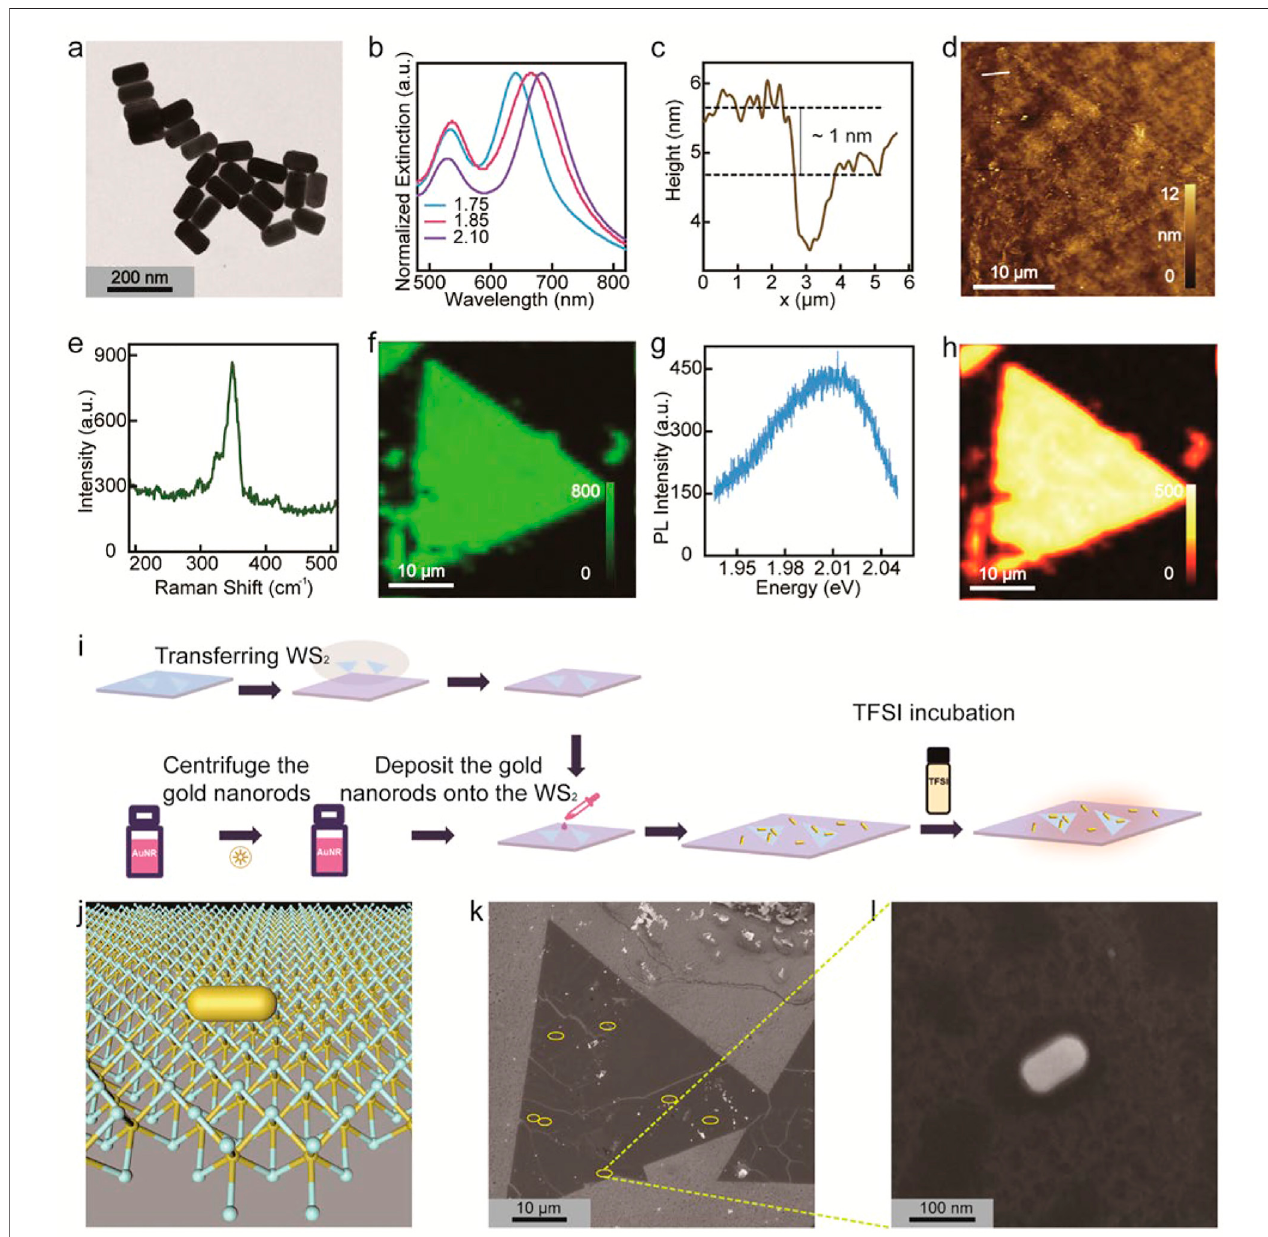
FIGURE 1 | Characterizations of gold nanorods and monolayer WS 2 . (A) Transmission electron microscopy (TEM) image of gold nanorods. (B) Normalized extinction spectra of three typical gold nanorod samples with different nanorod aspect ratios. Numbers next to the colored lines indicate the aspect ratios. (C, D) AFM topography (C) and image (D) of the monolayer WS 2 . The topography shown in (C) is collected along the white solid line shown in (D) . (E) Raman spectrum of the monolayer WS 2 fl ake. (F) 2D Raman intensity mapping of the sample corresponding to (D) . The mapping is monitored at 352 cm − 1 . (G) PL spectrum of the monolayer